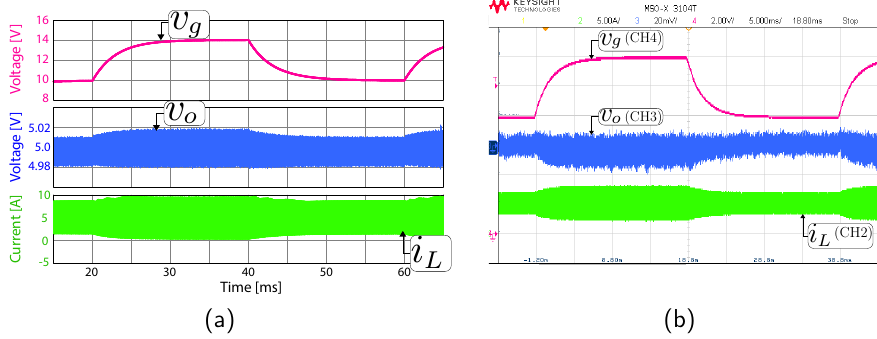
Figure 9. System line regulation. ( a ) PSIM simulation; ( b ) Experimental